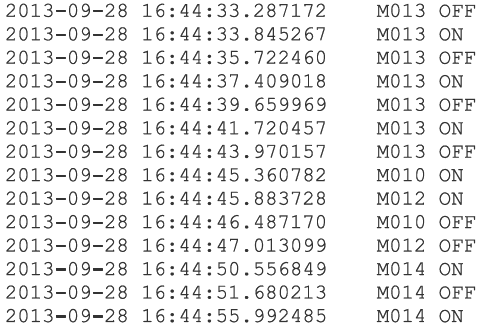
Figure 6. The raw data format in the CASAS datasets.